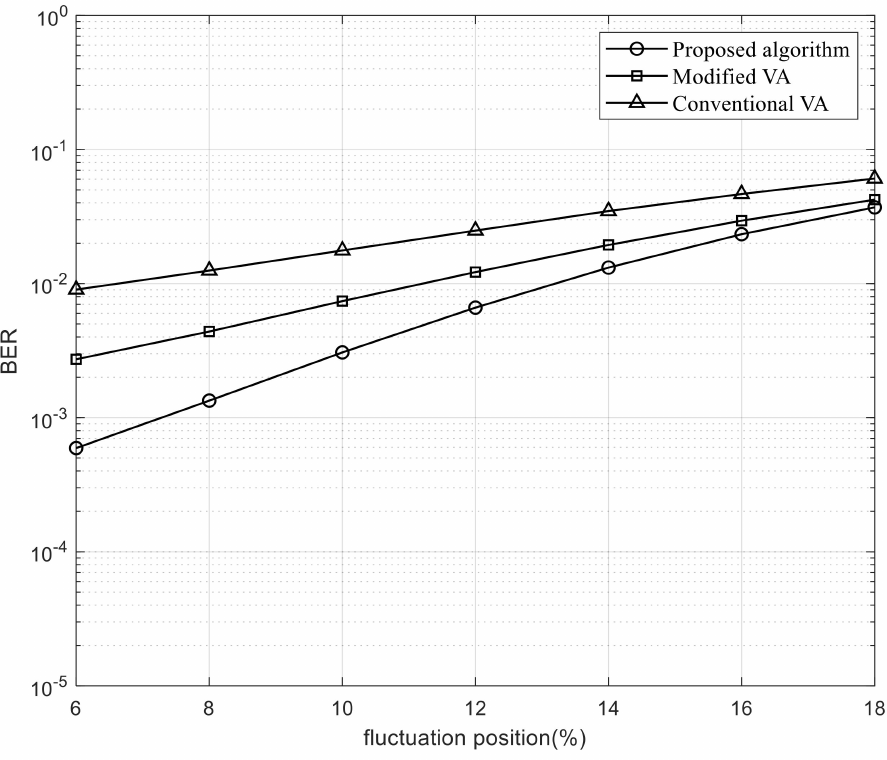
Figure 18. BER versus fluctuation position from 6% to